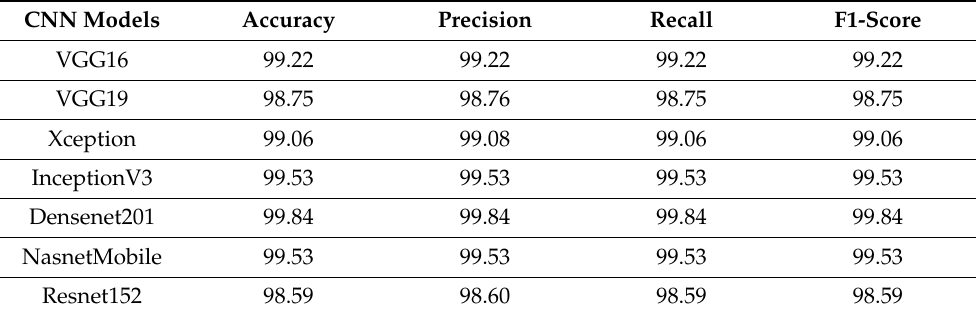
Table 4. Weighted average of performance metrics by different deep learning models for COVID-19 and bacterial pneumonia classification.